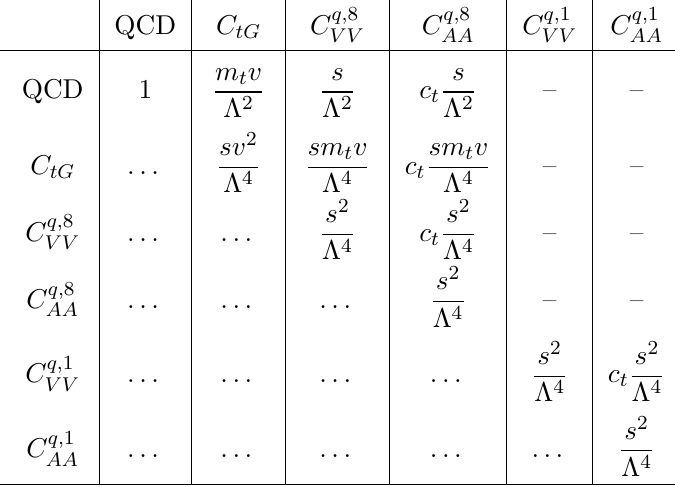
relative factor of 9/2 between quadratic contributions of color-singlet and color-octet oper- ators in eq. (2.12) is due to the color structure. For color singlets, the rate is proportional to the number of colors N of each quark current, yielding N 2 = 9. For color octets, it is c c proportional to P Tr( T A T B ) 2 = ( N 2 (cid:0) 1) = 4 = c AB